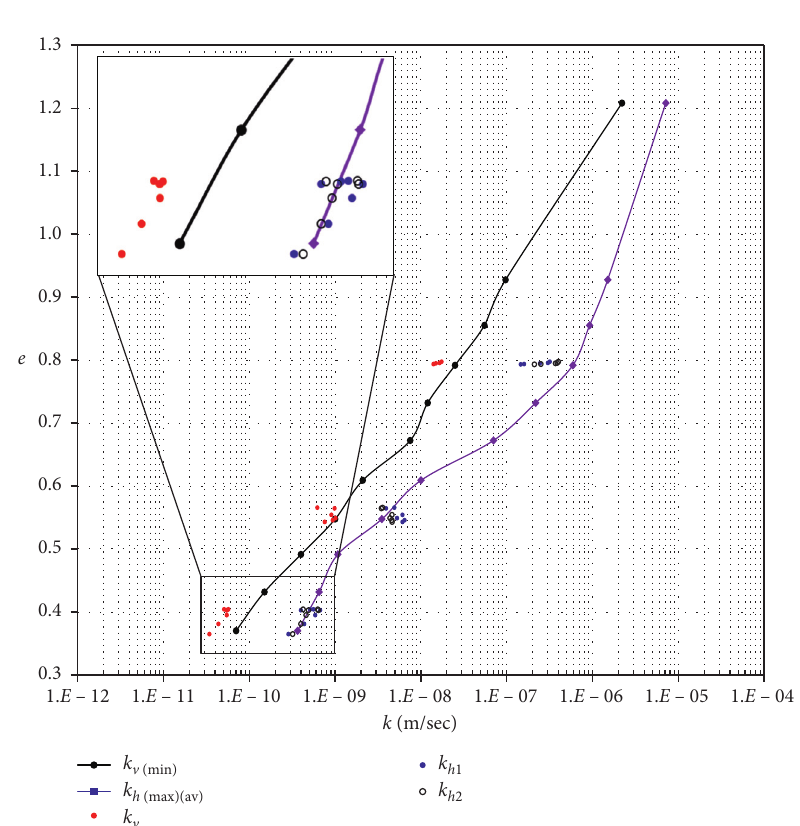
k v (min) curves for sample Ι